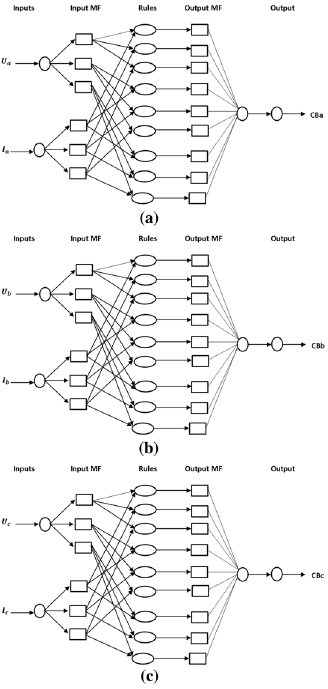
Fig. 6 ANFIS structures of proposed protection technique for studied system ( a ) ANFISa; ( b ) ANFISb; ( c )